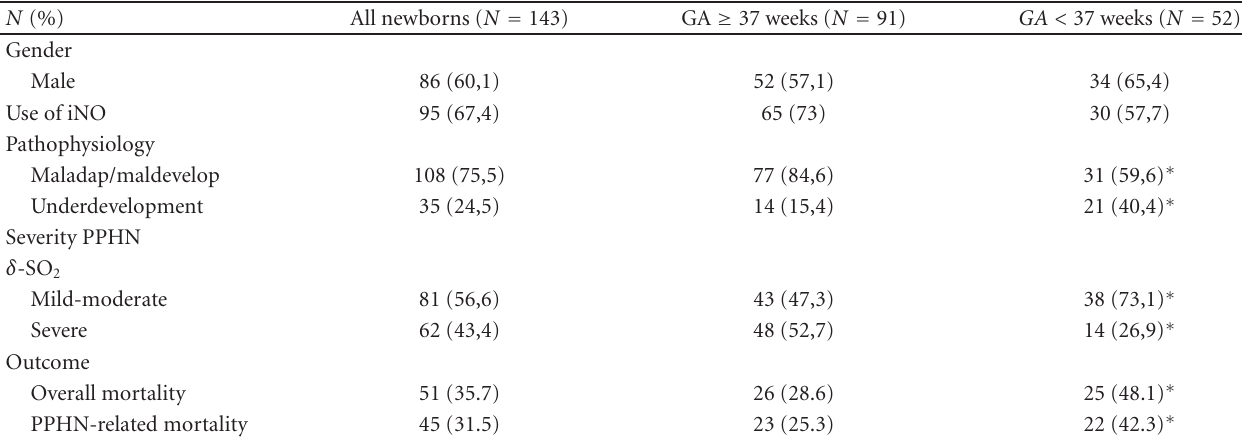
Table 1: Baseline characteristics of